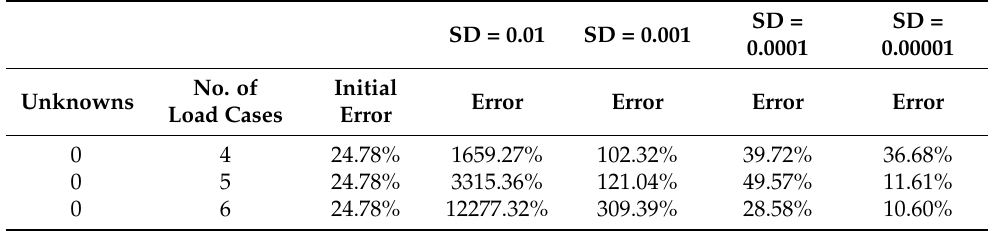
Table 11. Errors obtained for thermal parameters correlation for steady state 16 nodes model.